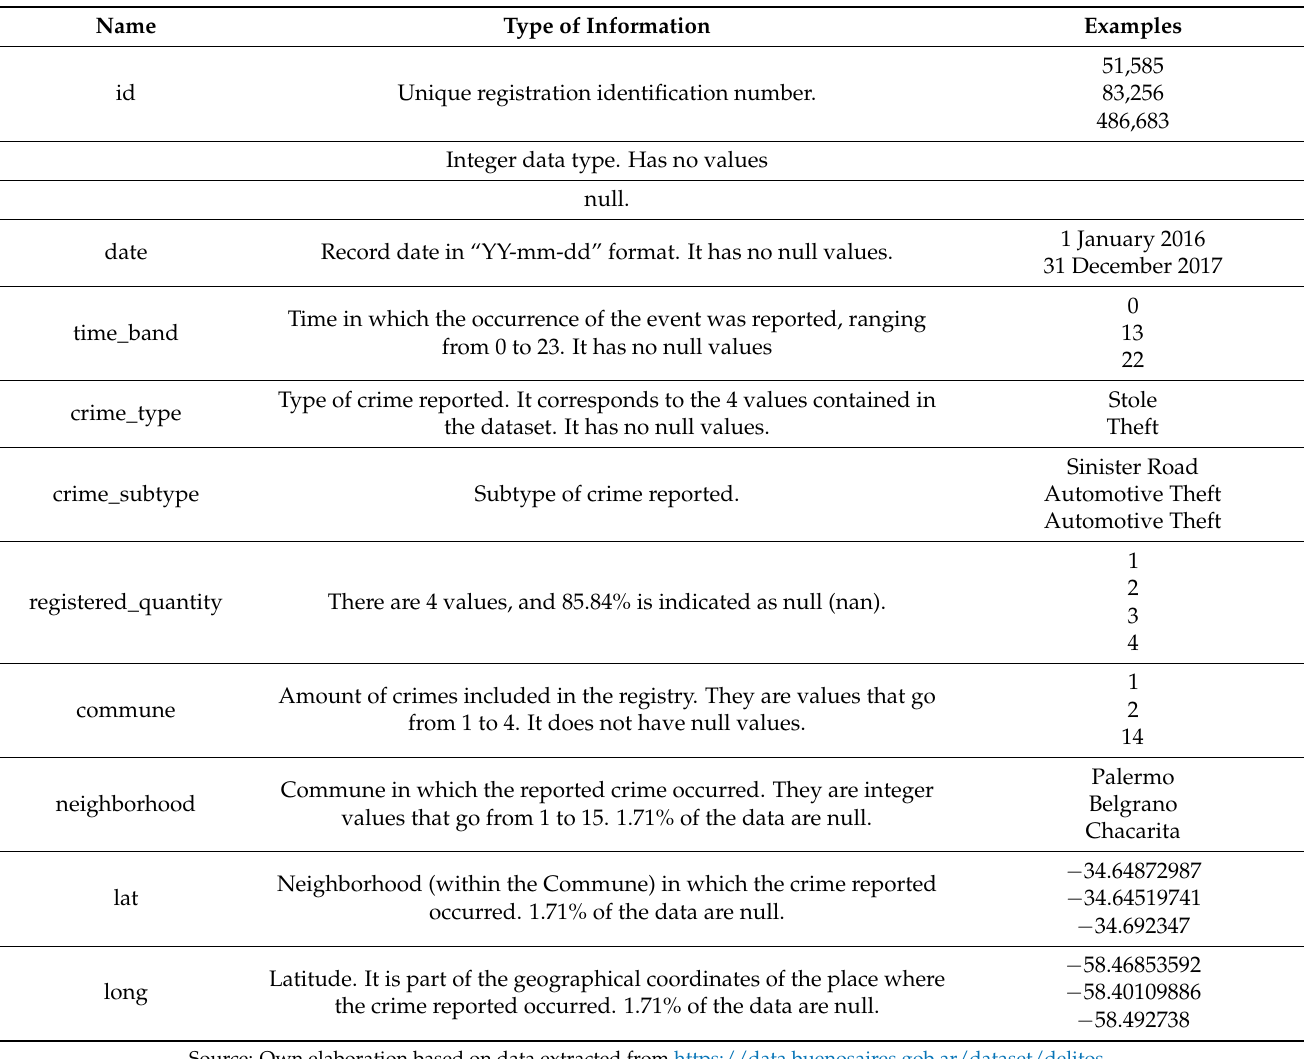
Table A1. Exploration of each column.